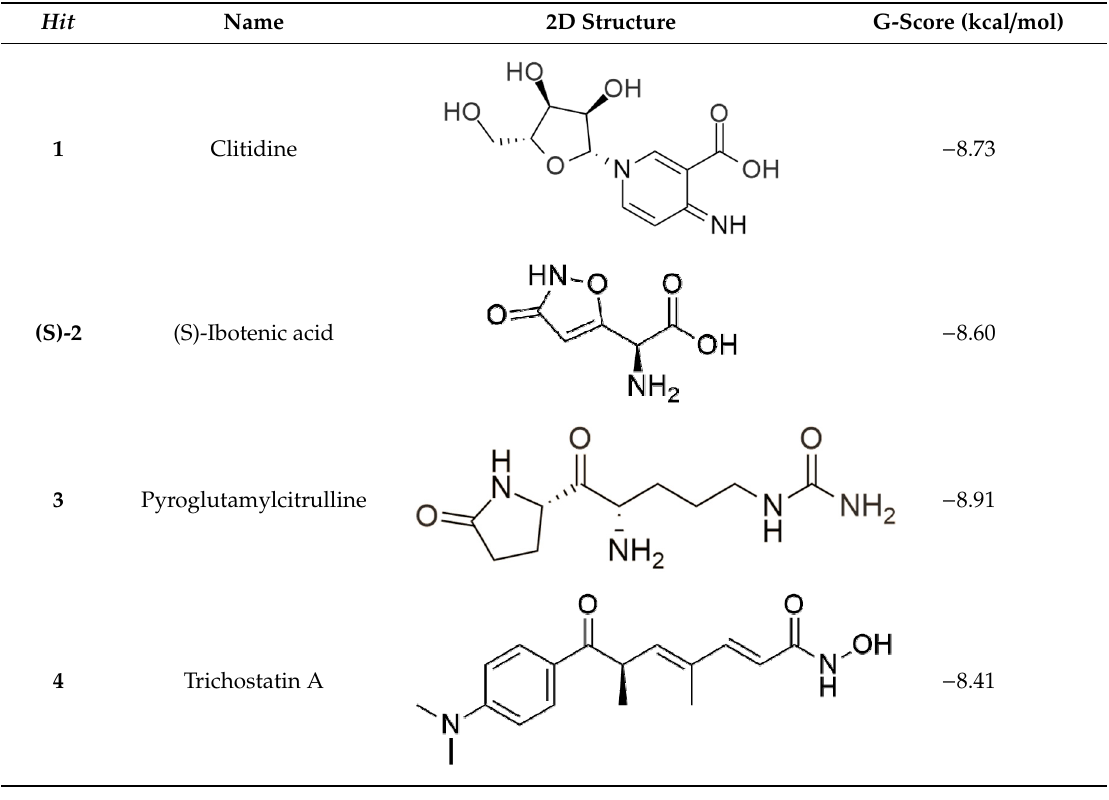
Table 1. Hit , Name, 2D structure, and G-Score value (kcal/mol) of the 3 best hits proposed as potential HDAC7 inhibitors and TSA.